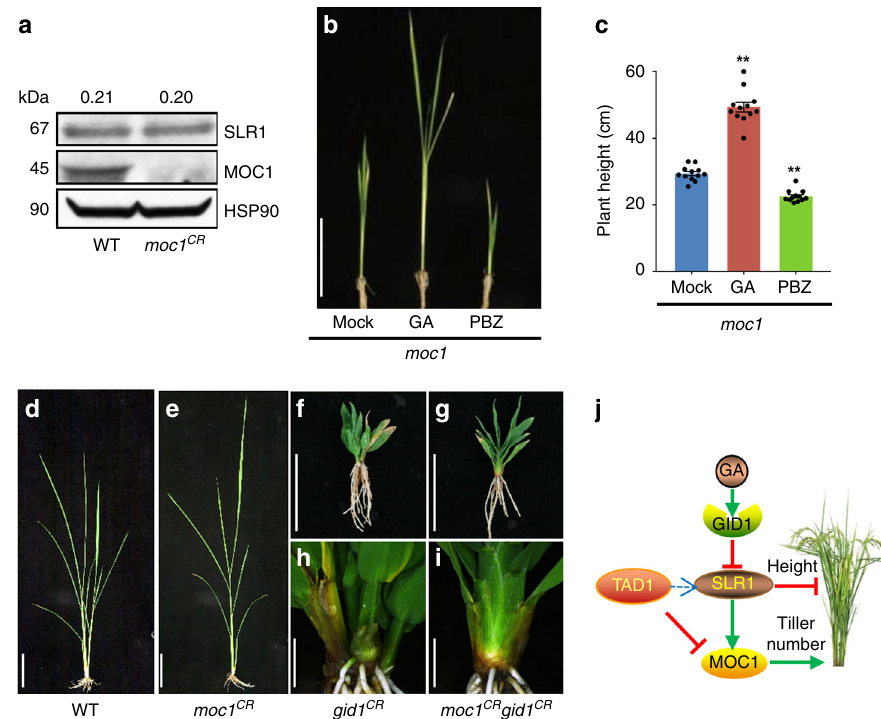
Fig. 5 Controls of plant height by GA independently of MOC1. a Protein levels of SLR1 and MOC1 in the WT and moc1 CR , determined by protein blotting using α -SLR1 and α -MOC1. HSP90, loading control. Values above panels indicate signal strength for SLR1 in arbitrary units determined by densitometry. The full scans of immunoblots are shown in Supplementary Fig. 12. b Effects of GA and PBZ treatments on plant height of moc1 . Scale bar, 20 cm. c Quantitation of the plant height shown in ( b ). Asterisks indicate signi fi cant difference to the mock (two-tailed Student ’ s t test, ** p < 0.01; mean ± s.e.m., n = 12). d – i Phenotypes of the WT, moc1 CR , gid1 CR , and moc1 CR gid1 CR after 2 months of growth. h , i show the magni fi ed shoot bases of ( f ) and ( g ), respectively. d , e Scale bar, 20 cm; ( f , g ), scale bar, 5 cm; ( h , i ), scale bar, 0.5 cm. j A model of GA signaling and MOC1 regulation of plant height and tiller number in rice. Source data are provided as a Source Data fi